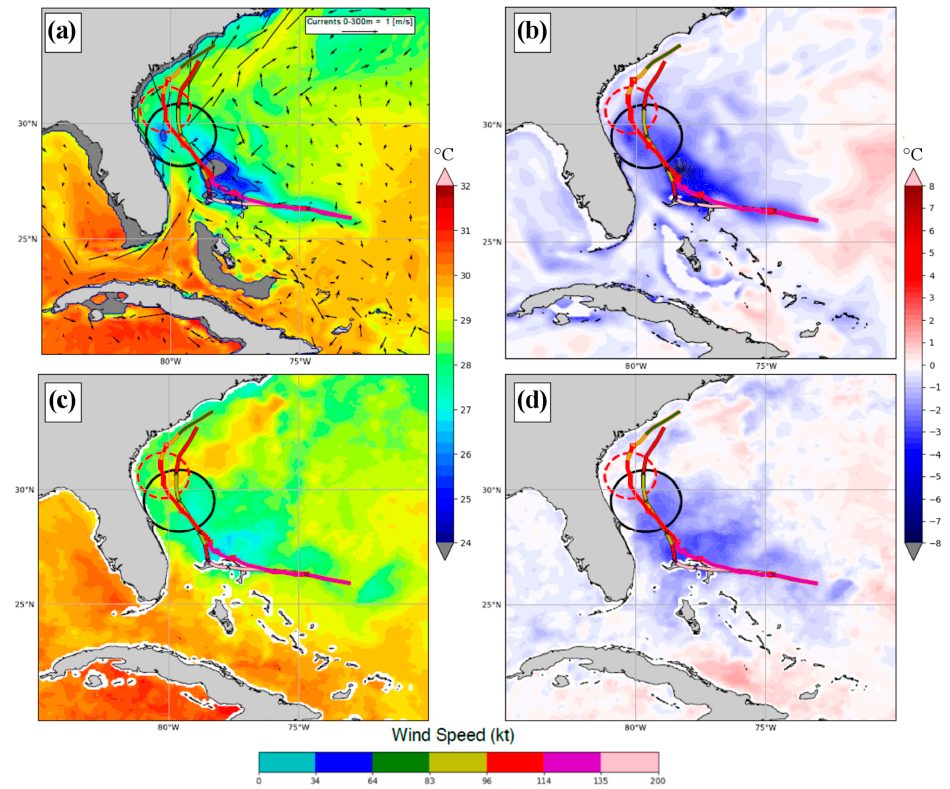
Figure 9. As in Figure 7, except for the case study of Dorian (AL052019), initialization time of 1200 UTC 31 August 2019. Fields shown are as of forecast lead time of 96 h (1200 UTC 04 September 2019): SST ( a , c ) and SST change ( b , d ) for ( a , b ) MPIPOM-TC model output and ( c , d ) MWIR satellite SST.